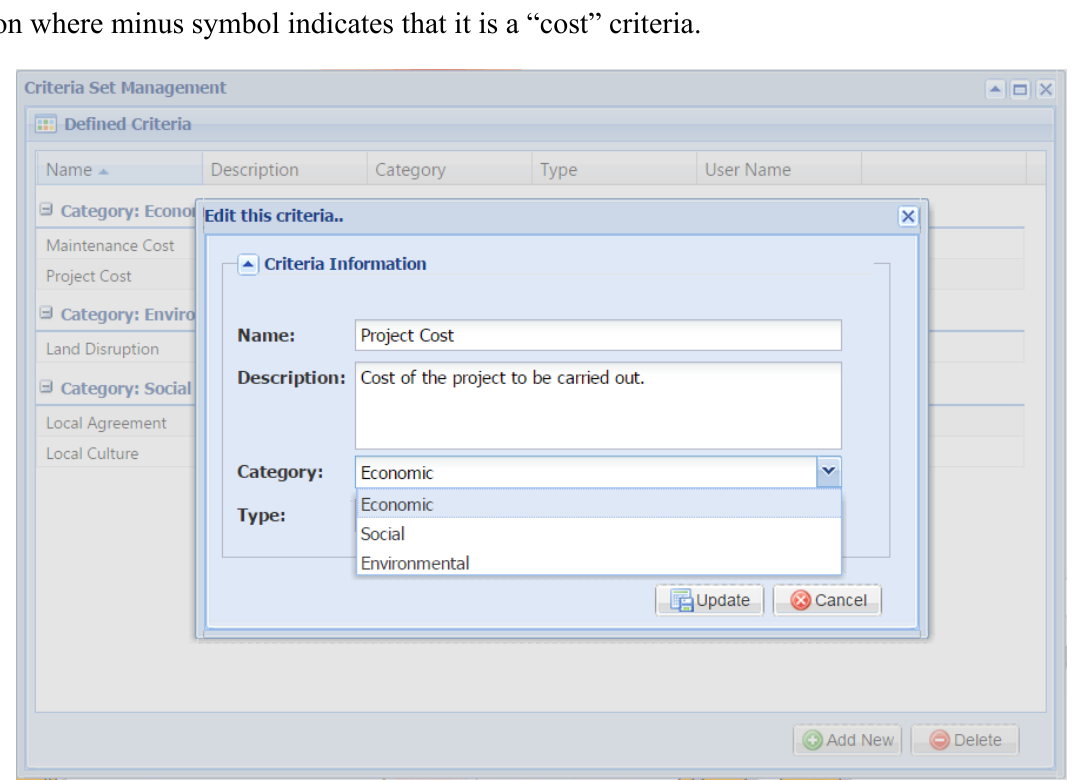
Figure 12. An example list of defined criteria for the study